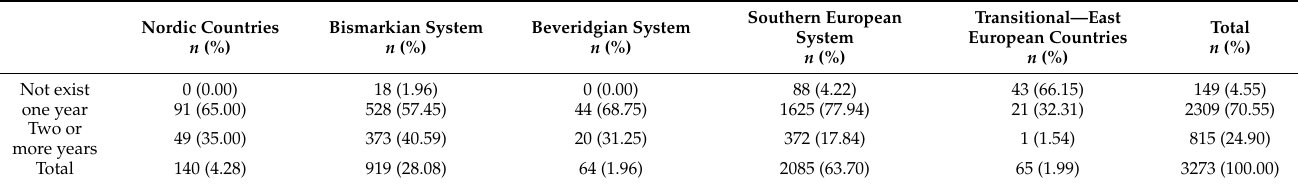
Table 3. Association between the oral health care system and vocational training .